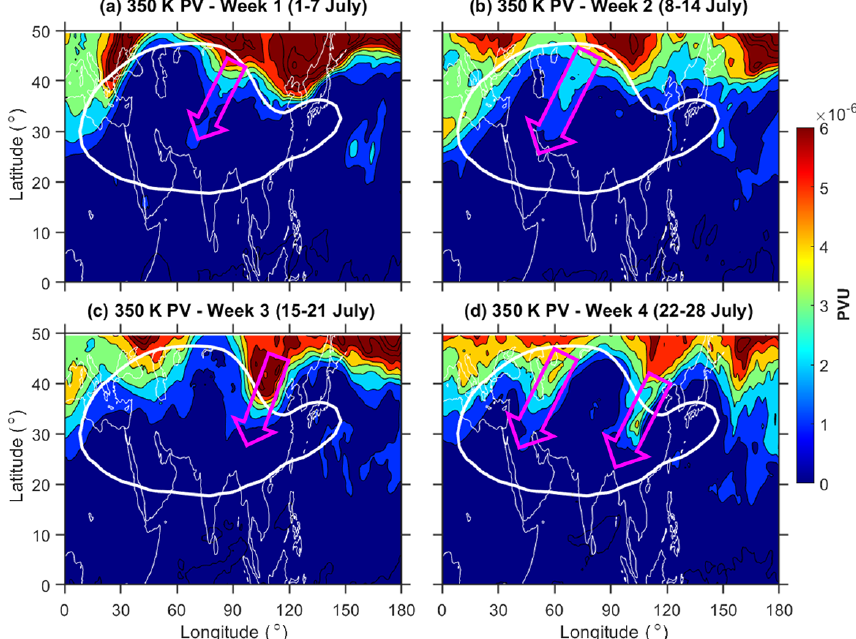
Figure 6. Same as Fig. 5 but for the weekly distribution of PV in July 2015. Magenta colored arrows indicate the regions of